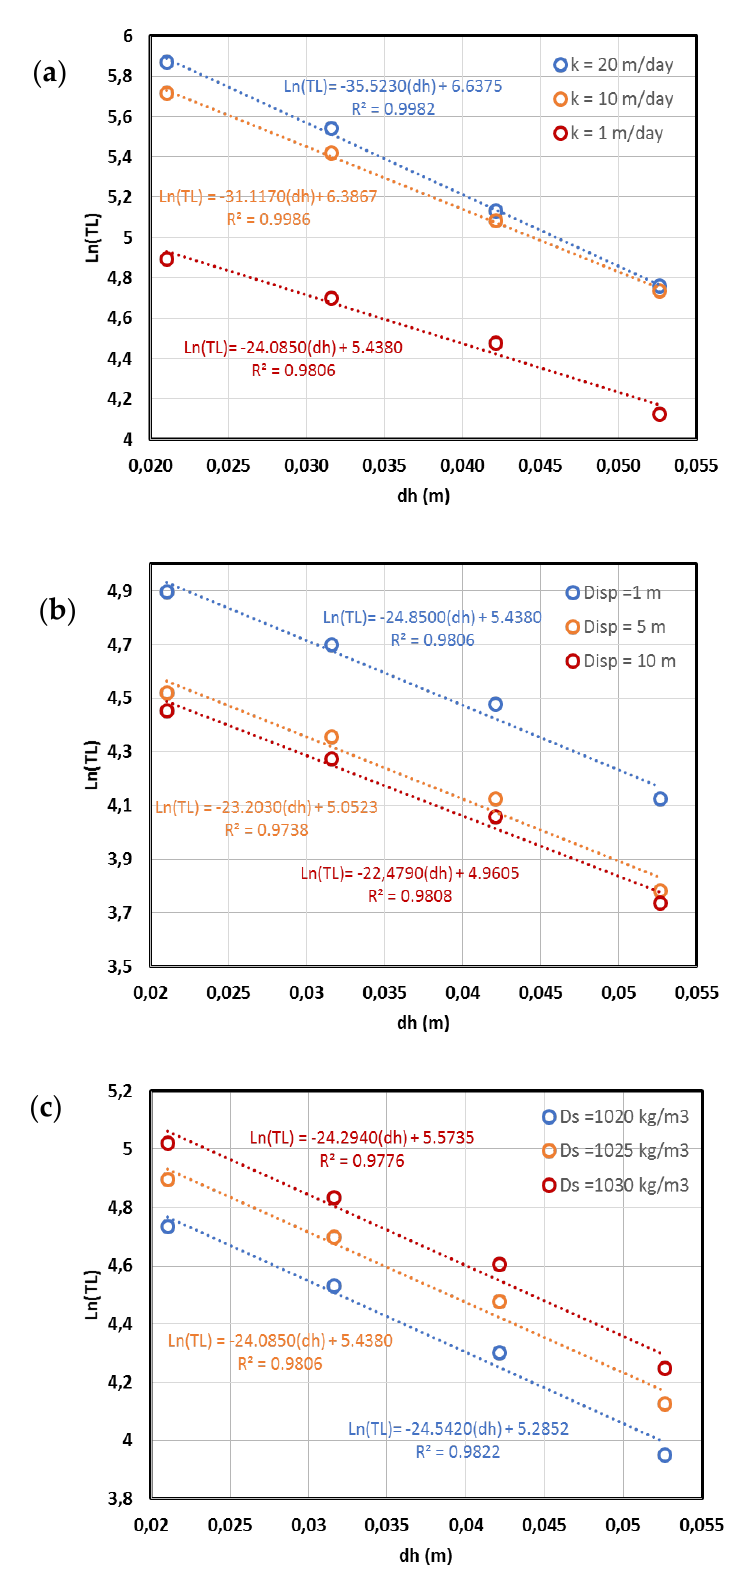
Figure 14. Change of the logarithmic toe length with the head difference for different values of ( a ) hydraulic conductivity, ( b ) dispersivity, and ( c ) saltwater density.